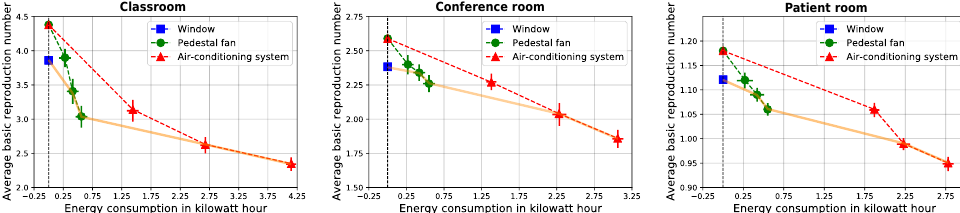
Figure 2. The energetic-epidemiological profiles for open window (blue square), pedestal fan (green dots), and air-conditioning system (red triangles) across three room types. The results shown as average ± standard deviation over 90 min. The x-axis indicates the average energy consumption in kilowatt hour of the air ventilation solution and the y-axis indicates the average basic reproduction number. The dashed black vertical line indicates no energy consumption. The solid orange line is the Pareto